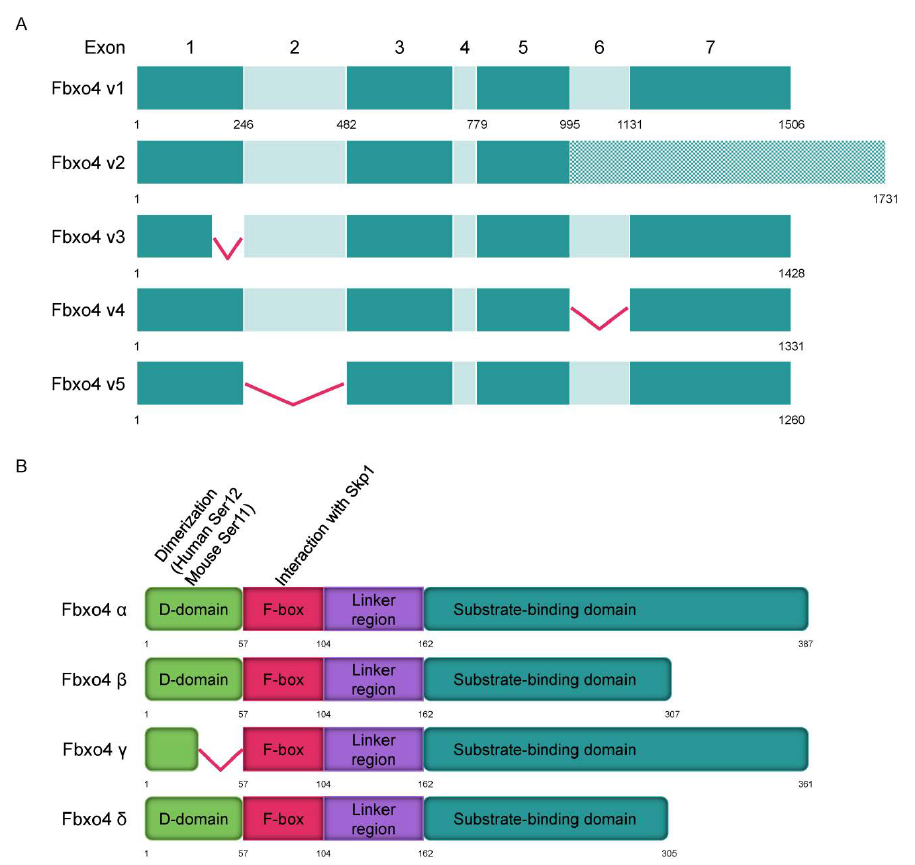
Figure 2. The transcript variants of FBXO4 and protein structure of different isoforms. ( A ) Five transcript variants of FBXO4 are shown in schematic plots. ( B ) Four different isoforms of Fbxo4 are identified with four domains: D domain for dimerization, F-box domain for forming SCF complex, Linker region, and substrate binding domain. As shown in Figure 2B, Fbxo4 molecule has four domains from N- to C-terminus: D domain for dimerization, F-box domain for the formation of SCF complex, Linker region and substrate binding domain [34]. Structural analyses combined with biophysical and biochemical techniques revealed the full-length Fbxo4 is deficient in E3 ubiquitin ligase strate binding domain is indispensable for dimerization. Additionally, the N-terminal domain can interact with Cul1-Rbx1 besides functioning for dimerization [35]. The screening of human esophageal squamous cell carcinoma (ESCC) tissues identified the existence of Fbxo4 mutations, such as S8R, S12L, P13S, L23Q, and G30N in D domain, and P76T mutation in F-box domain, leading to loss of function of Fbxo4 [21]. In addi- tion, other mutations in the FBXO4 gene have also been discovered in tumor tissues from the TCGA PanCancer Atlas Studies (Figure 3A), and in cells from the Cancer Cell Line Encyclopedia (Broad, 2019) on the cBioportal website (Figure 3B) [36,37]. In accord- ance, there are consistent mutations when comparing these bioinformatic findings from previous studies [21]. For example, the mutations located in the F-box domain can com- promise the formation of SCF complex.